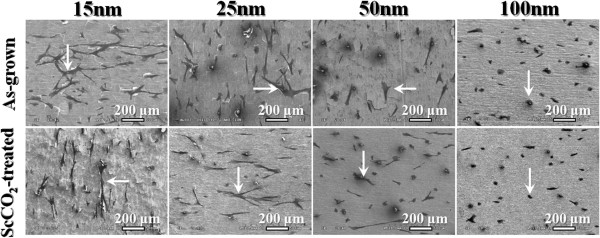
SEM images showing the cell adhesion and proliferation of human fibroblast cells. On the as-grown (upper column) and ScCO2-treated (lower column) TiO2 nanotubes of different diameters.